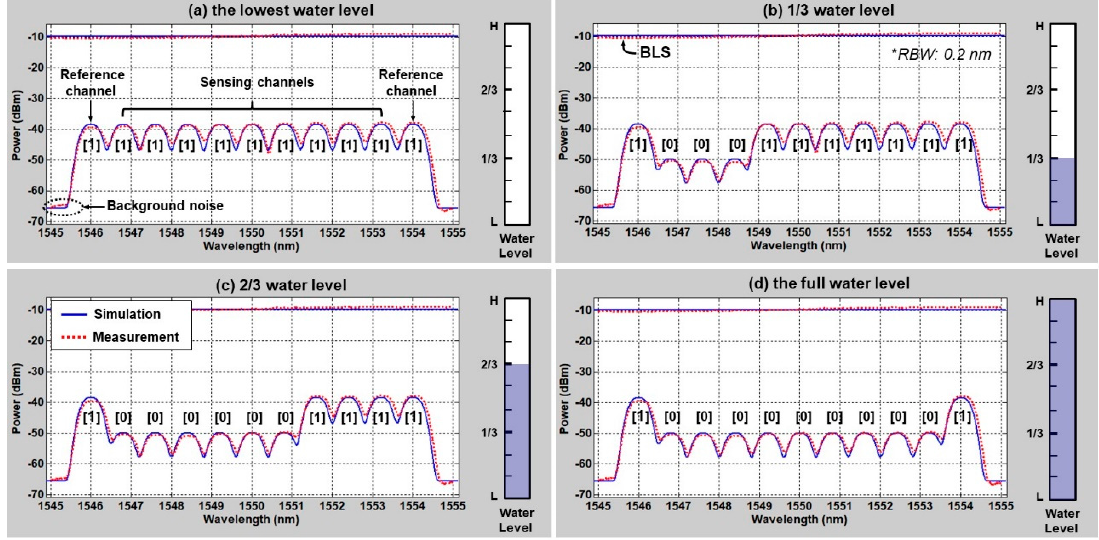
Figure 9. Water level measurement spectrum for four different water levels: ( a ) empty (0 height steps), ( b ) 1/3-full (3 height steps), ( c ) 2/3-full (6 height steps), and ( d ) full (9 height steps). Adapted from Lee et al. [50].